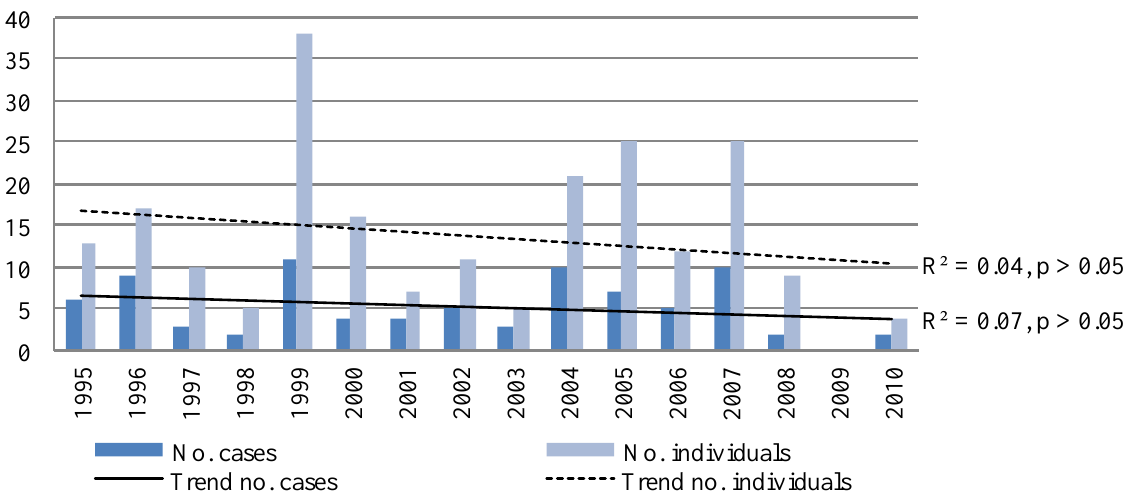
Figure 3. Number of SAR cases and individuals assisted per year in Nain from 1995 to